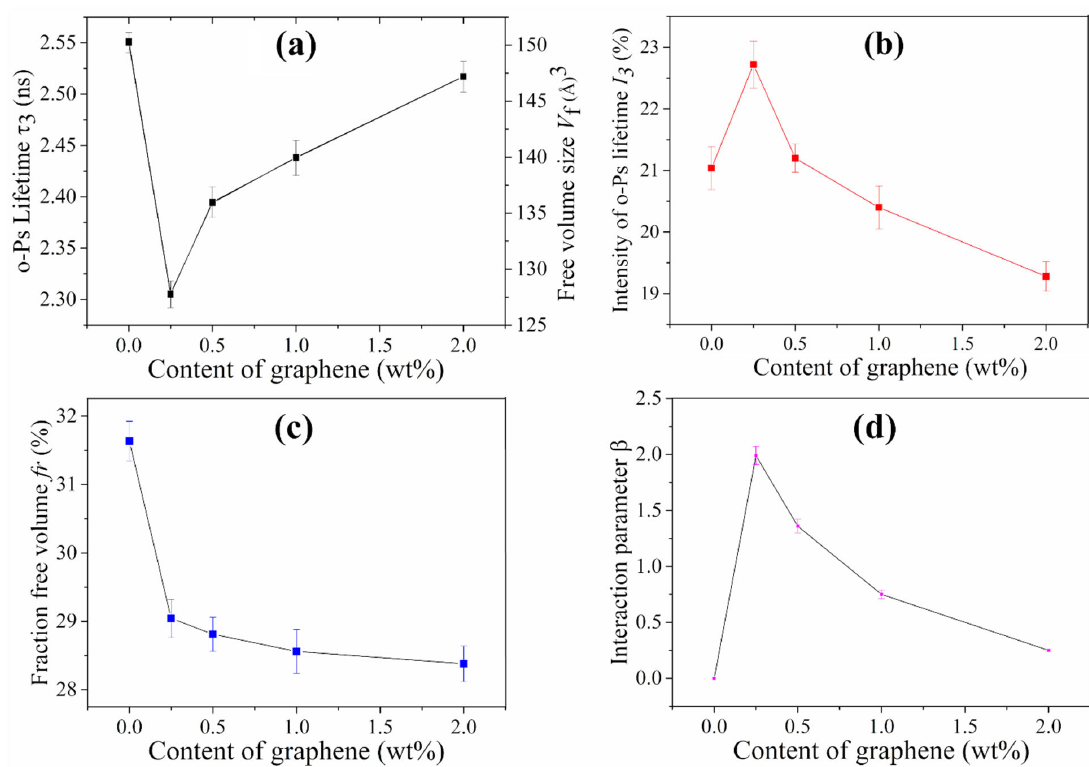
Figure 2. ( a ) Long lifetime ( τ 3 ) and free volume size ( V f ); ( b ) long lifetime intensity ( I 3 ); ( c ) relative free volume fraction ( f r ); ( d ) interaction parameter ( β ) of the graphene/PE composites.